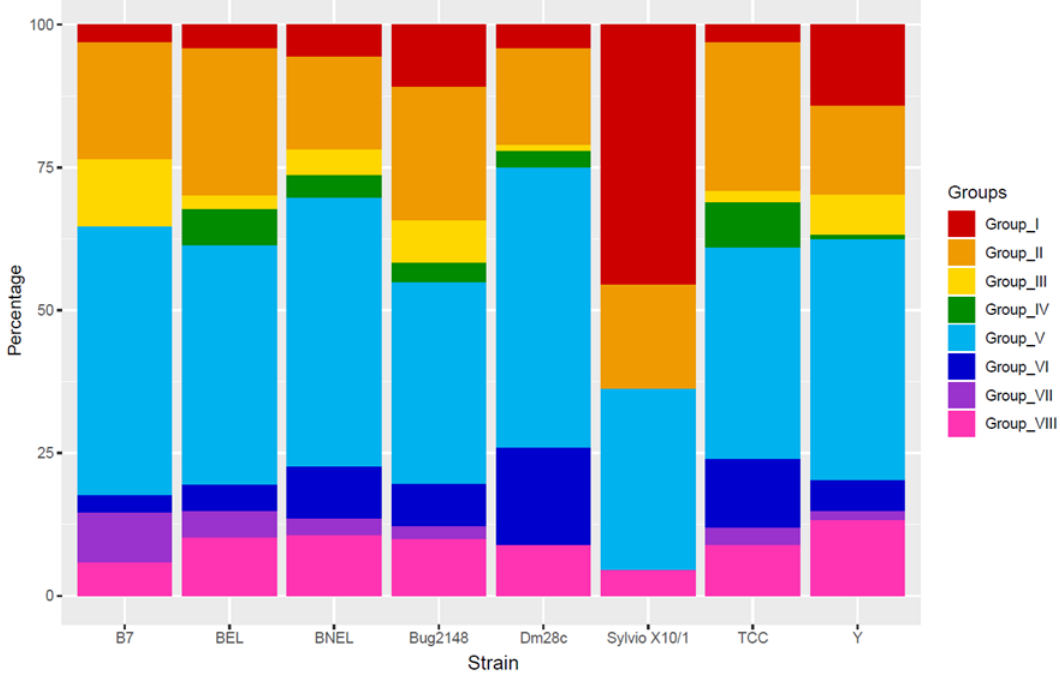
Figure 6. TS group distribution in genomes of different strains of T. cruzi and B7 strain of T. cruzi marinkellei . The percentage of each TS group is displayed. BNEL: CL Brener Non-Esmeraldo-like; BEL: CL Brener